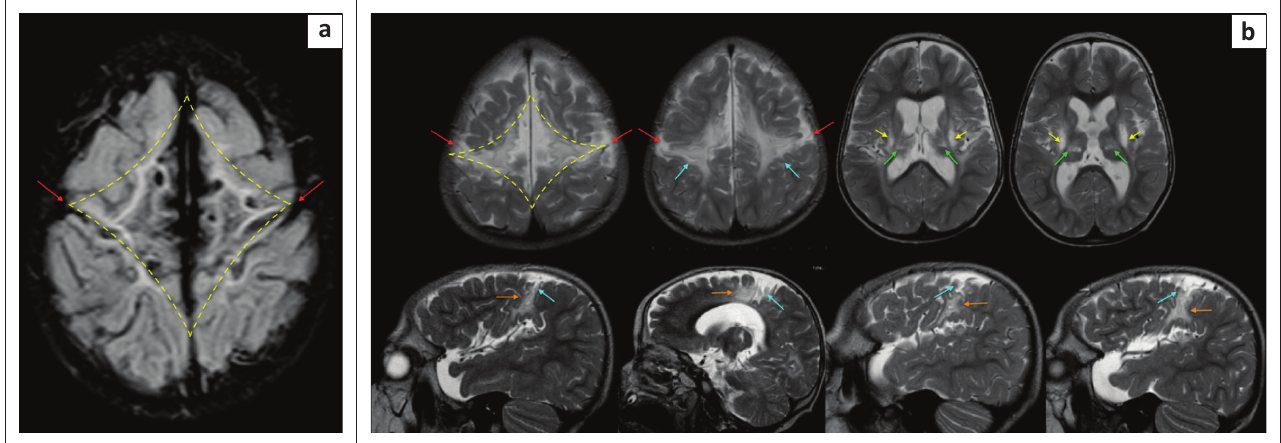
FIGURE 20: Two examples of parasagittal cerebral injury in children who suffered sentinel events of placental abruption leading to acute profound ischemia (API). (a) This figure shows a diamond-shaped expansion of the frontoparietal parasagittal surface convexity, widening the interhemispheric fissure and tapering bilaterally at the far edge of each central sulcus (red arrows). (b) This figure reveals similar broadening of the extra-axial space because of parasagittal cortex and paracentral lobule injury. Note the contiguous corticospinal tract Wallerian degeneration (orange arrows), the subsiding centrum ovale scaffold (cyan blue arrows) as well as API-related basal ganglia (yellow arrows) and thalamic (green arrows)